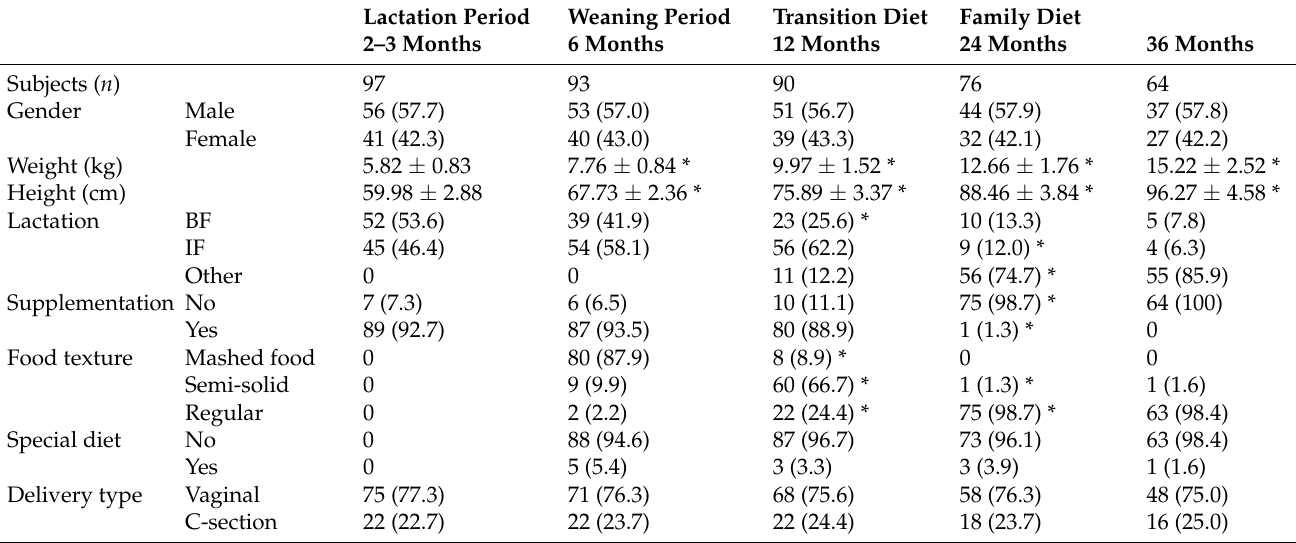
Table 2. General characteristics of the cohort by